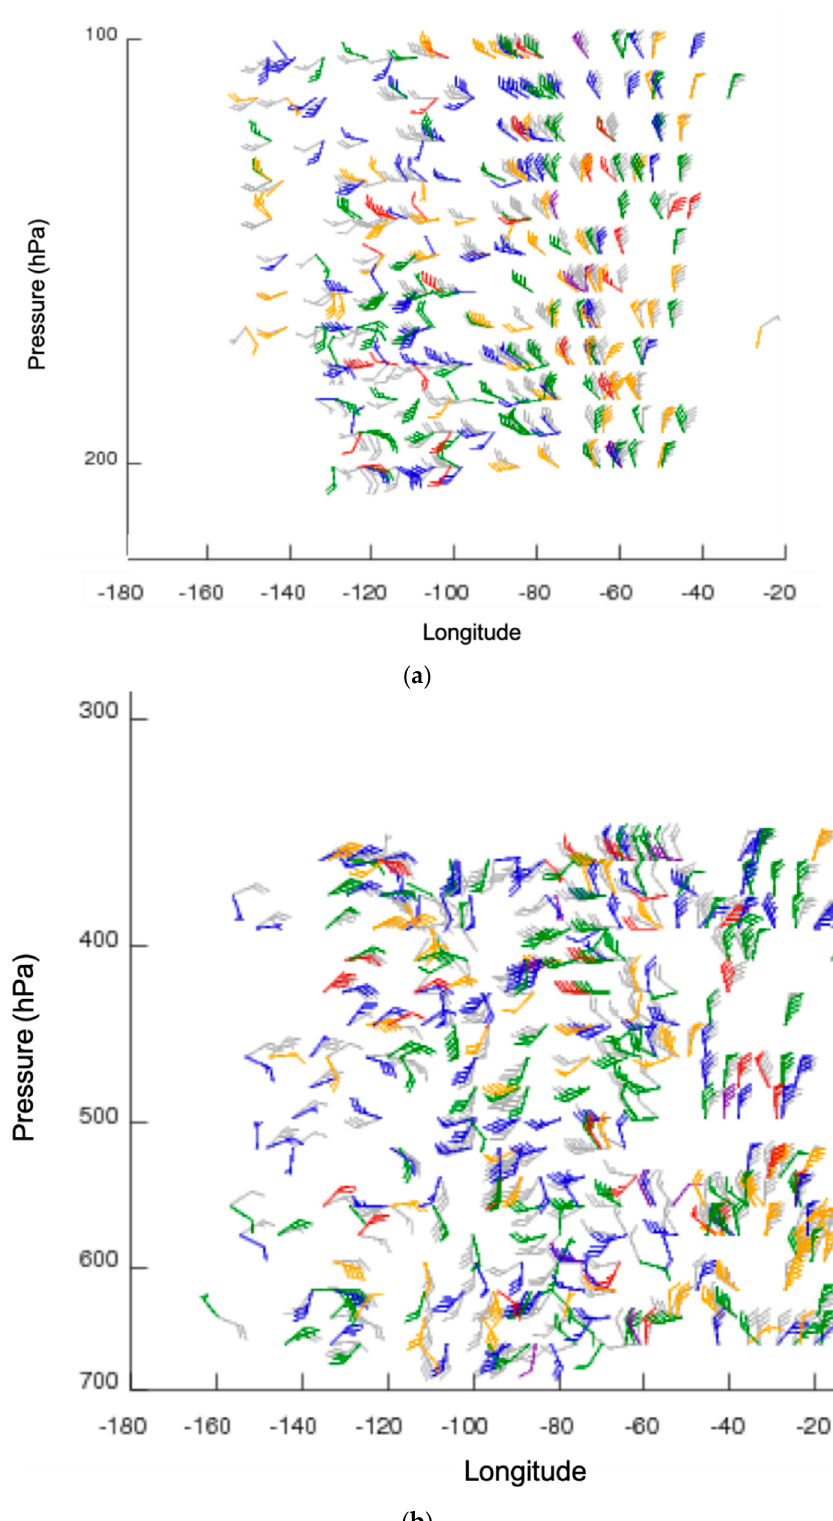
Figure 6. Vertical distribution of AIRS retrieval winds over the north pole region: ( a ) upper panel is ozone AMVs; ( b ) lower panel is humidity AMVs. All derived winds from 6 January 2011 at 1200 UTC. Colors denote distance from the north pole: blue (far) to red (close). Gray is a model analysis. Note: This is one-half day of winds, which results in one-half of the daily longitudinal coverage.